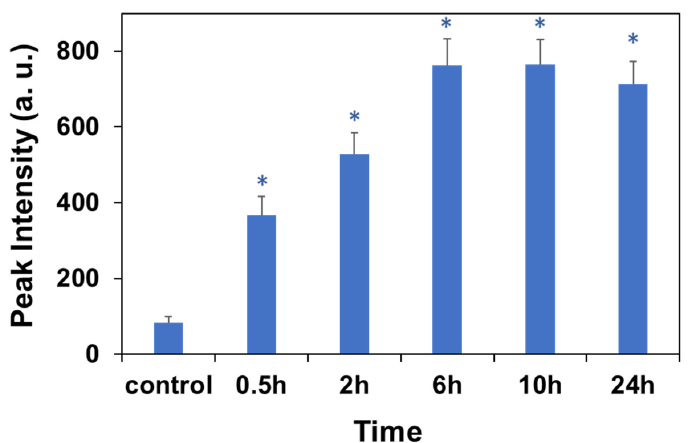
Figure 4. Light intensity of nucleus region of cells with 750 µg/mL of CNDs incubation as a function of time for incubation. The error bar shows the standard deviation. * Stands for a significant difference from the control (0 mg/mL) ( p < 0.05) via a statistical analysis.